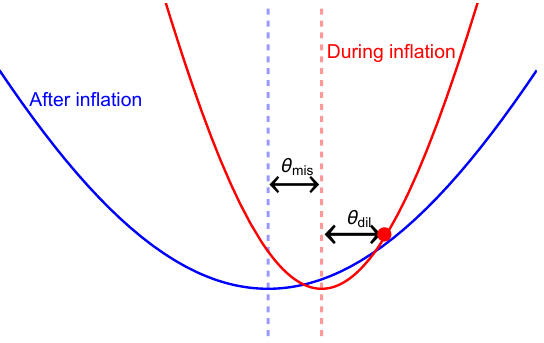
Figure 1 . A schematic picture of the scenario. Red: axion potential during in(cid:13)ation; blue: axion potential after in(cid:13)ation. The red dot represents the axion at the end of the in(cid:13)ation. Dashed vertical lines indicate the minima of the